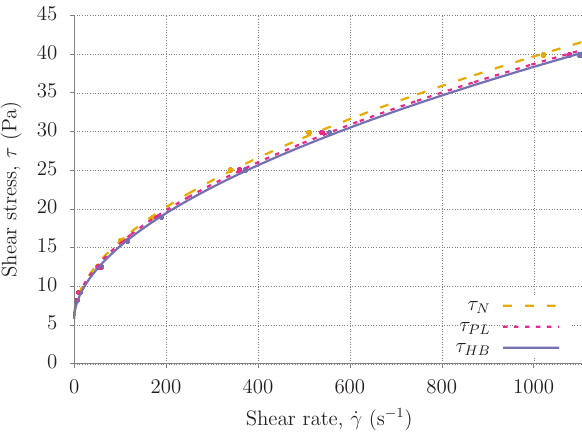
Figure 8: Herschel-Bulkley model fitting of the spacer fluid mea- surements listed in Table 1. We plot fits assuming both standard Newtonian shear rates, power law shear rates and Herschel-Bulkley shear rates. Table 3: Newtonian, power law and Herschel-Bulkley wall shear rates for the spacer fluid measurements in Table